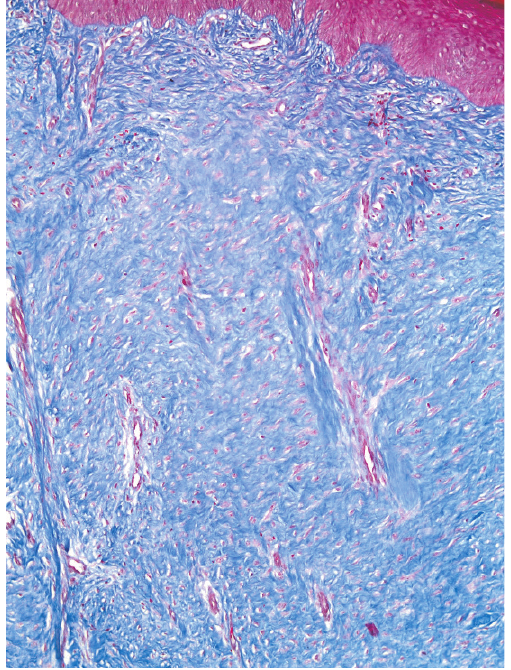
Figure 3 - The histology of hypertrophic scars is characterized by replacement of the papillary and reticular dermis by scar tissue with prominent vertically oriented blood vessels. The fibrous bundles are parallel and horizontal in the upper dermis. (Masson’s trichrome, 100X). of previous surgical excision and by the positivity of the sclerotic neurofibroma cells for the protein S100 (22). Other rare, benign keloid and HTS-like diseases include keloidal granuloma (23), erythema elevatum diutinum (24), infantile digital fibromatosis (25), dermatofibroma,(26) penile edema (27), pseudoangiomatous hyperplasia (28) and lichen sclerosus (29).